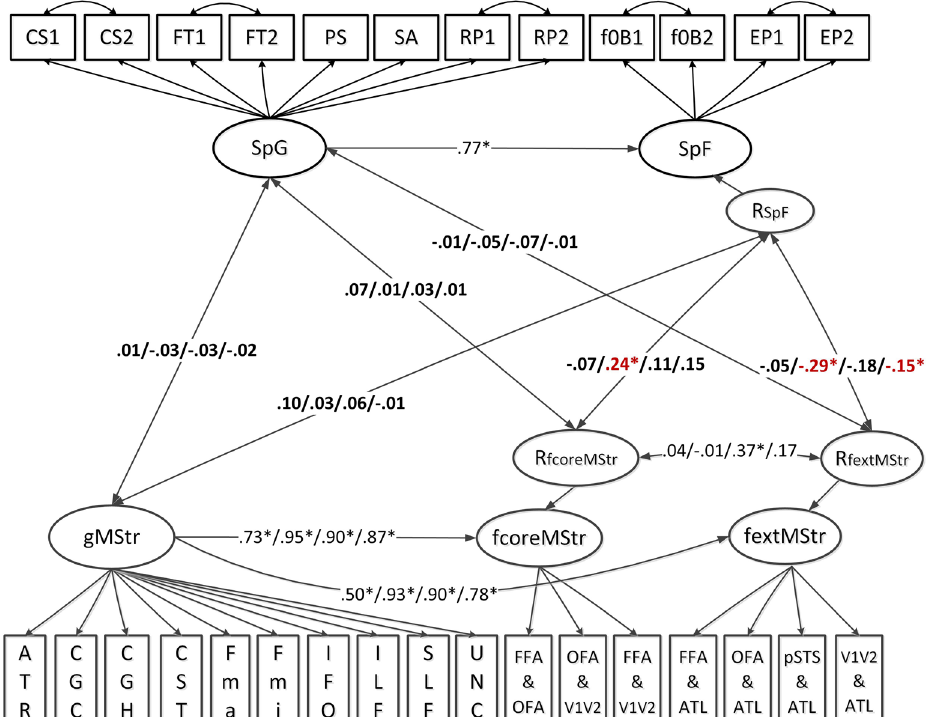
Figure 1. Schematic representation of the structural equation model estimating the linear relationship between individual differences in tract-averaged white matter microstructural properties (FA/MD/AD/ RD) and processing speed ability both at the domain general and face-specific levels. SpG—Speed of general cognition; SpF—Speed of face processing; gMStr—Microstructural properties in global brain fibers; fcoreMStr— Microstructural properties of core face network fibers; fextMStr—Microstructural properties of extended face network fibers; RfcoreMStr—Residual variance of the fcoreMStr factor, indicating the unique variance in fcoreMStr not explained by gMStr; RfextMStr—Residual variance of the fextMStr factor, indicating the unique variance in fextMStr not explained by gMStr; RSpF—Residual variance of the SpF factor, indicating the unique variance in SpF not explained by SpG; CS1—Dimensional change card sort task, color domain; CS2—Dimensional change card sort, shape domain; FT1—Flanker inhibitory control and attention task, congruent condition; FT2—Flanker inhibitory control and attention task, incongruent condition; PS—Pattern comparison processing speed; SA—Sustained attention; RP1—Relational processing, first scan as indicator 1; RP2—Relational processing, second scan as indicator 2; f0B1—Facial working memory 0-back task, first scan as indicator 1; F0B2—Facial working memory 0-back task, second scan as indicator 2; EP1—Facial emotion processing, first scan as indicator 1; EP2—Facial emotion processing, second scan as indicator 2. Information on the fiber indicators is provided in Fig. 7. For all the four diffusion metrics, correlated residuals of major fibers included ATR-CGC, ATR-Fmin, CGC-Fmin and UNC-Fmin. Additionally, for the measures of MD, AD and RD, residual covariances of ATR-UNC, SLF-IFO, CGC-UNC, ILF-SLF and ILF-IFO were also